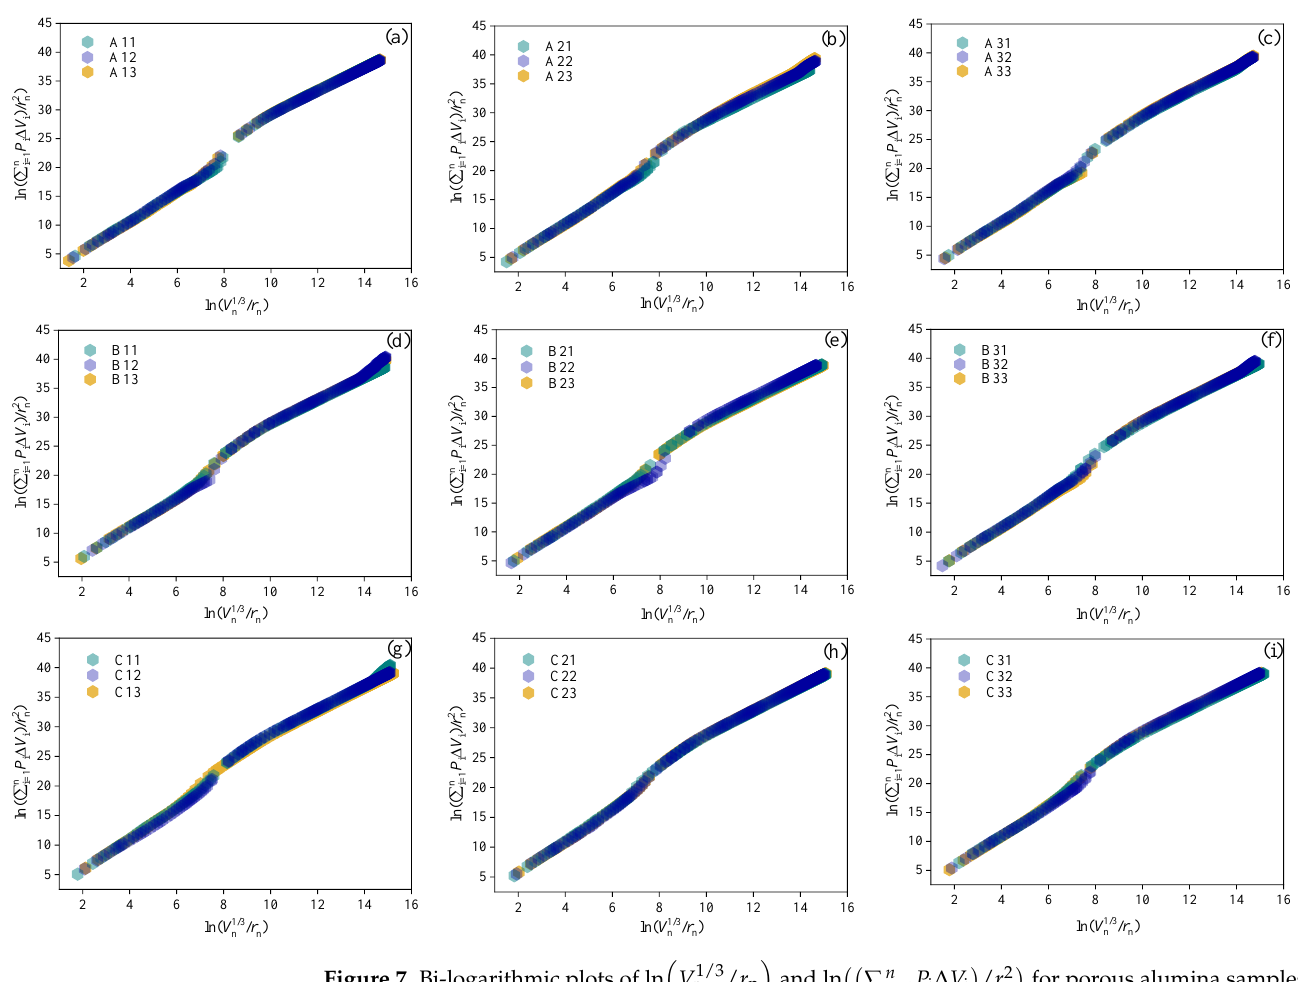
(cid:16) (cid:17) (cid:0)(cid:0) ∑ n (cid:1) (cid:1) and for porous alumina samples V 1/3 n / r n P i ∆ V i and ln / r 2 n for porous alumina samples i = 1 n1 / 3 i𝑛𝑛 n2 i=1 ∆𝑉𝑉 i )/ 𝑟𝑟 ln ( 𝑉𝑉 / 𝑟𝑟 n ) ln � ( ∑ 𝑃𝑃 �